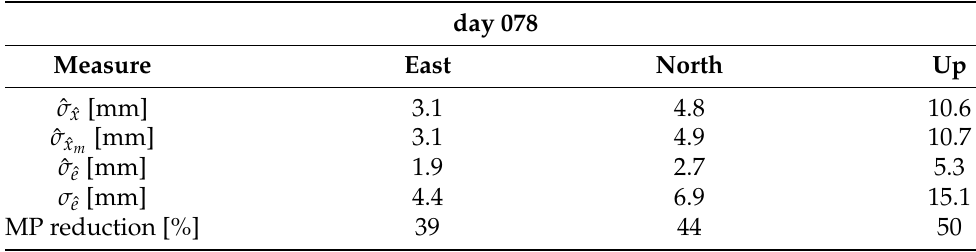
Table 3. Baseline-based MP correction effectiveness on day